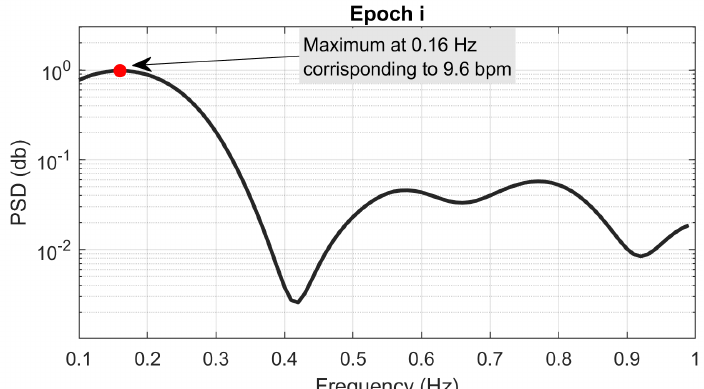
Figure 6. Example of a Power Spectral Density (PSD) estimated from an i epoch. The local maximum was highlighted by the red dot, and it was at a frequency of 0.16 Hz (corresponding to a breathing rate of 9.6